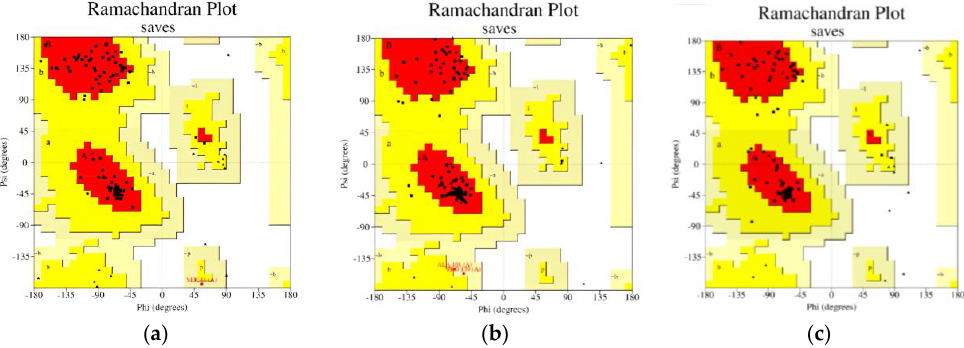
Figure 3. Ramachandran plot for ( a ) Wuhan-Hu-1 and EIJK-61453 Vaccine Model, ( b ) UGM0002 Vaccine Model ( c ) B.1.1.7 Vaccine